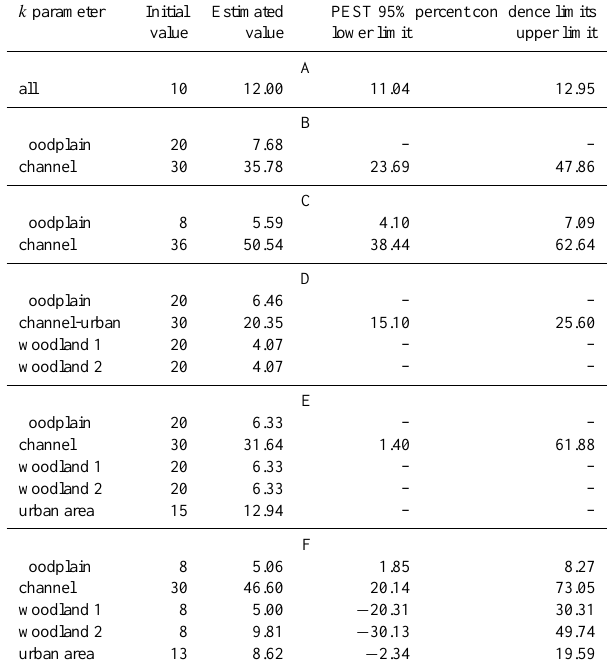
Table 2. Final roughness estimations and confidence bounds for the calibration scenarios given by PEST. Note: in case of conditioned parameters no confidence bounds can be